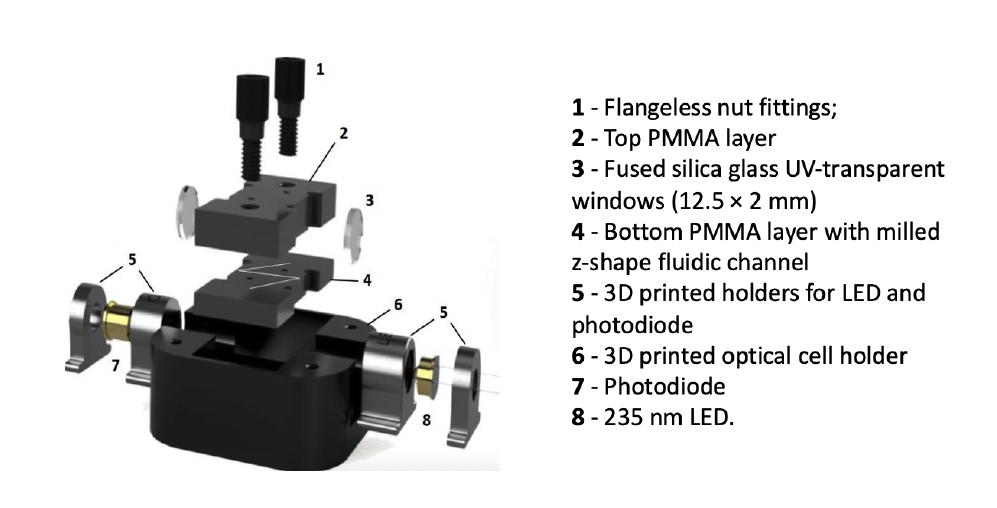
Figure 19. Integrated fused silica windows with a PMMA microfluidic device for UV-Visible ab- sorbance detection. Reprinted from [123], copyright © Elsevier